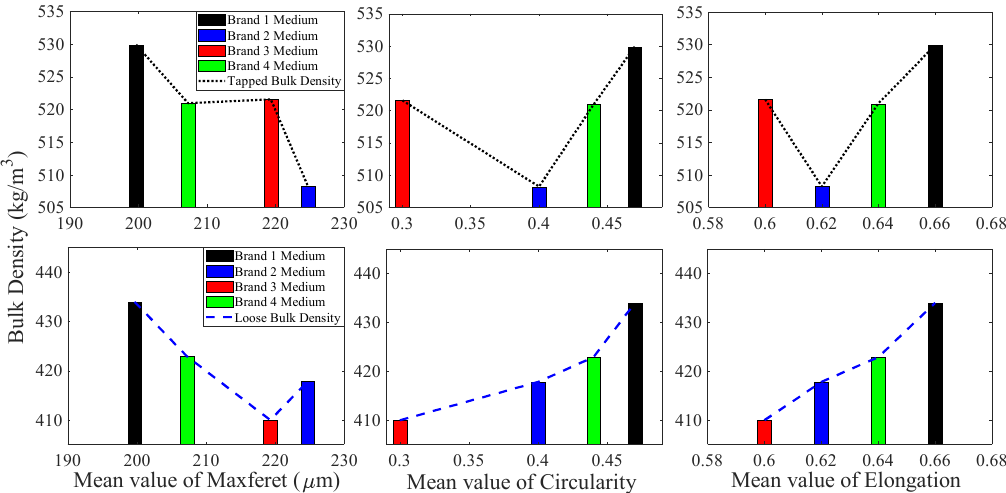
Figure 7. Tapped and loose bulk density of four different brands of instant whole milk powder versus mean values of shape factors for medium sized particles.